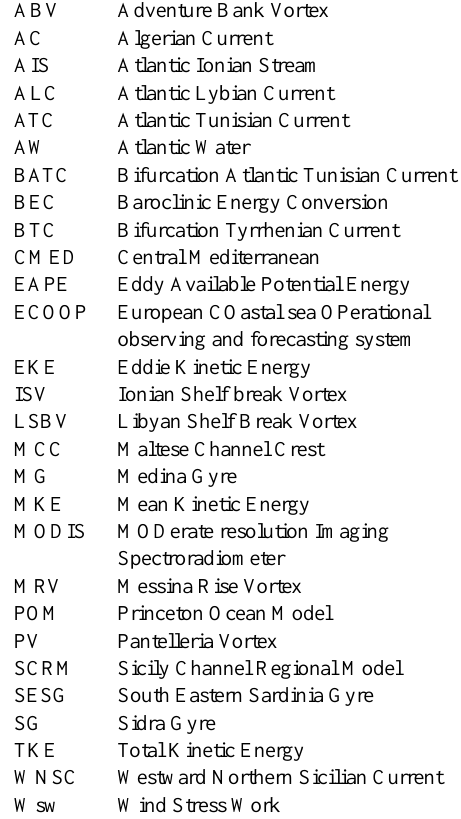
Table 1. Acronyms and